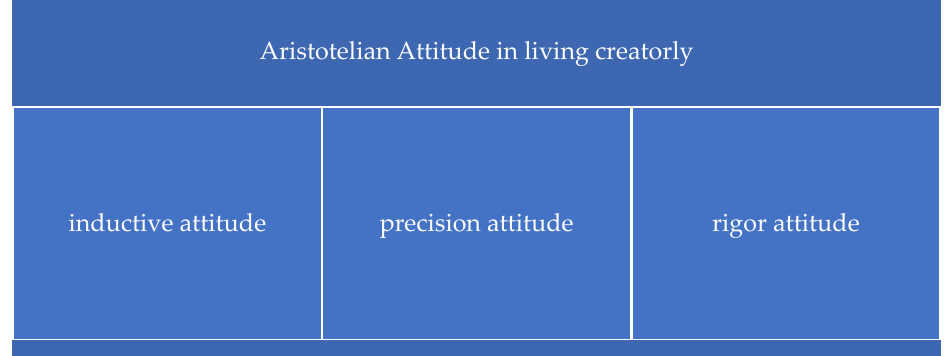
Figure 4. Claudia’s attitude with living creatively comes forth in inductive attitudes and precision and rigor. Source: Claudia’s interviews about problem.